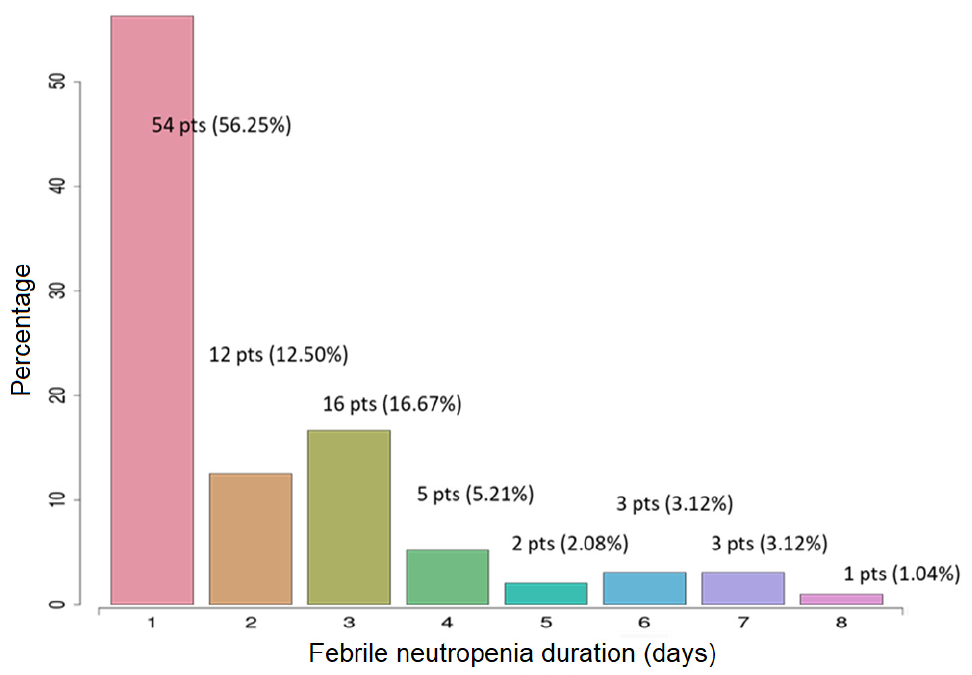
Figure 2. Repartition of aplasia among the included patients.